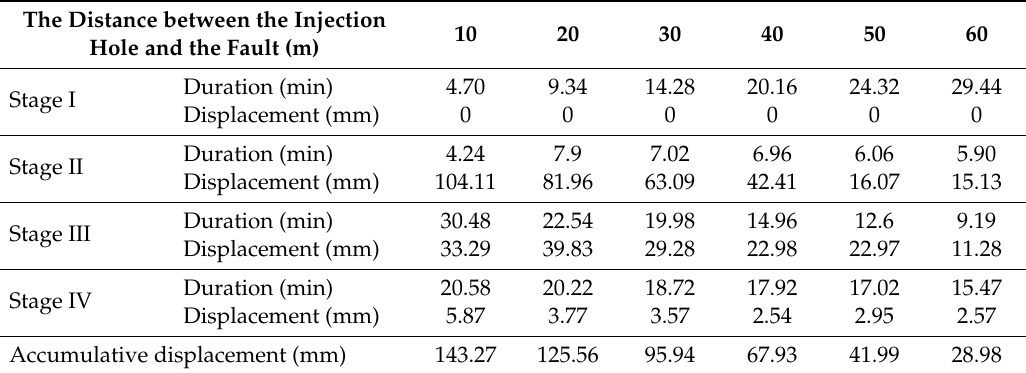
Figure 12. Change of displacement of fault slip when the distance between the injection hole and the fault ranged from 10 to 60 m. Table 3. Duration time and fault slip displacement at four stages when the distance between the injection hole and the fault ranged from 10 to 60 m.